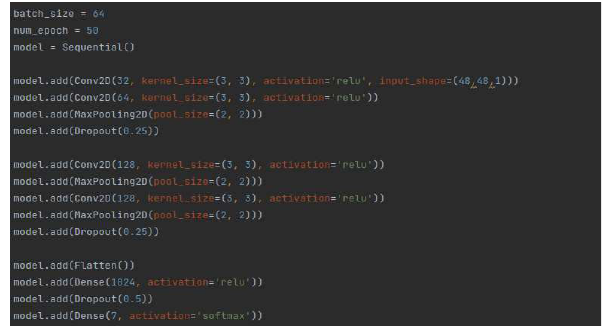
Figure 6 . Model implementation